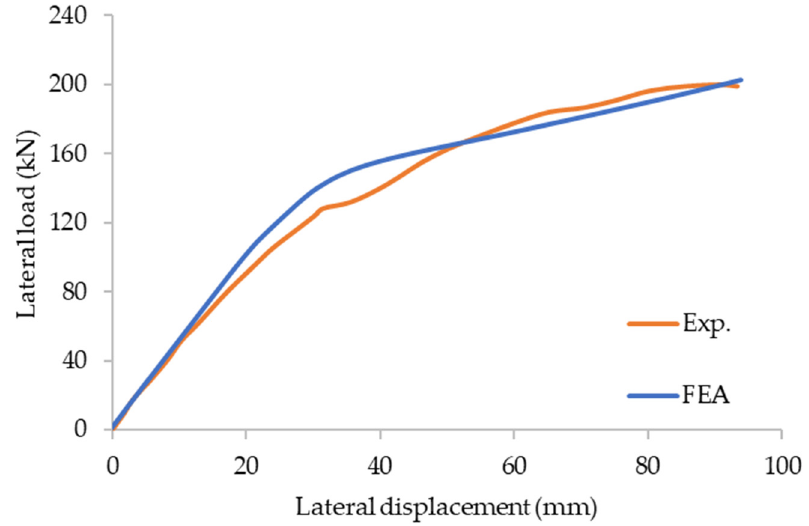
Figure 3. Test [28] and FE lateral load-deflection curves.